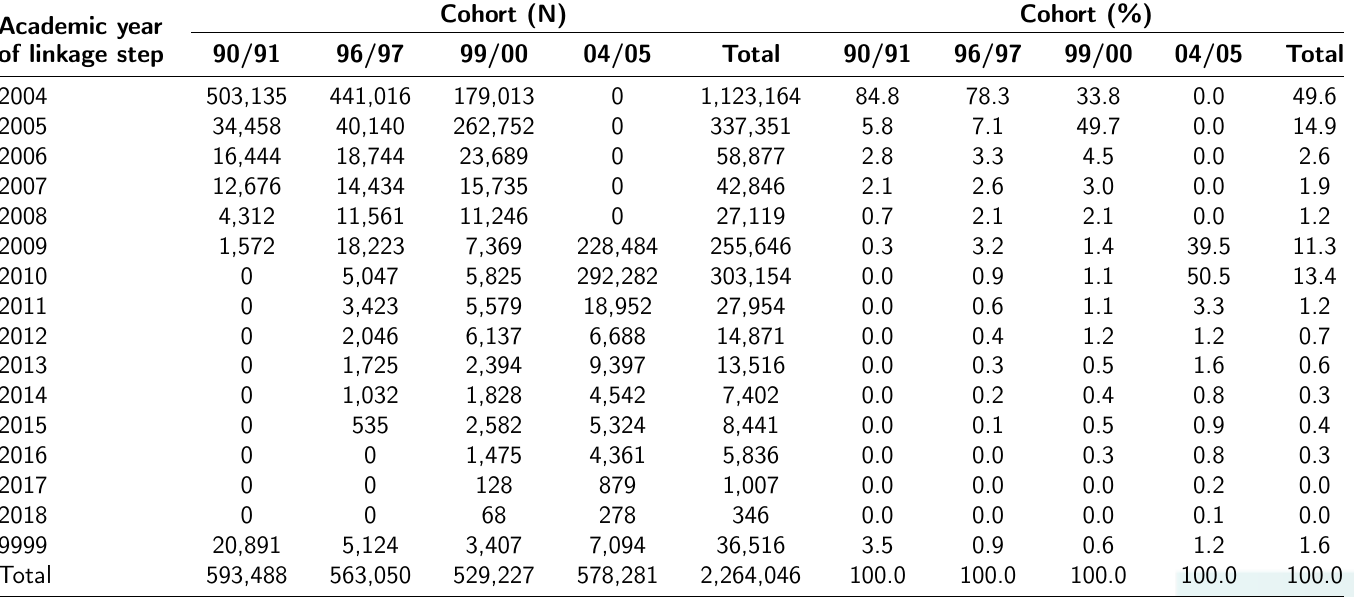
Supplementary Table 6.2: Linkage national pupil dataset to personal demographics service by academic year of linkage step and cohort (all